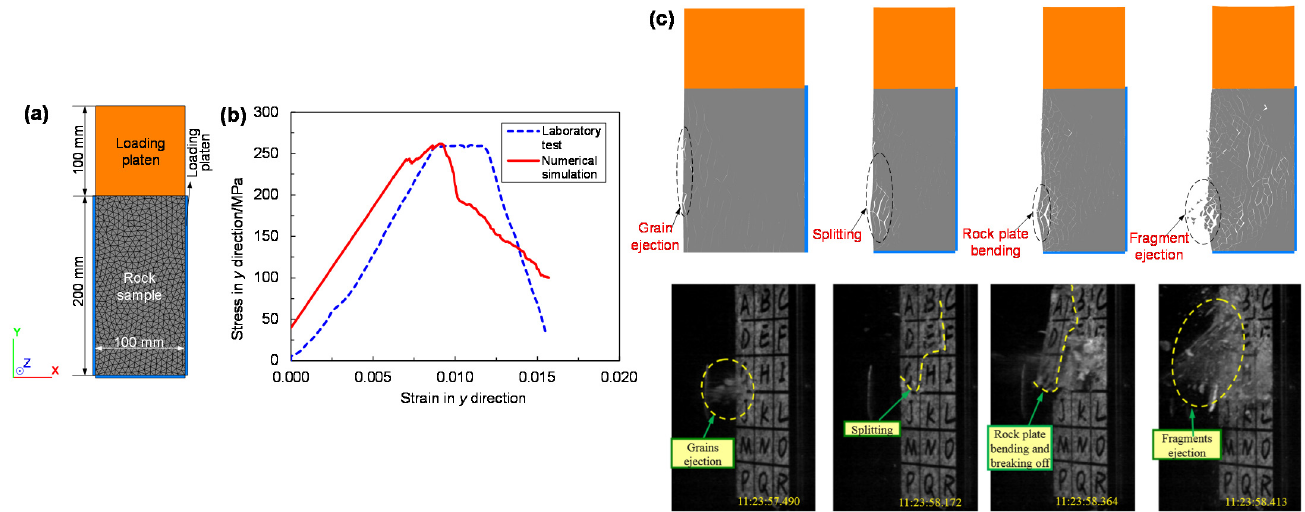
Figure 2. A numerical model for simulating self-initiated strainbursts and the comparison between the simulation and experimental results: ( a ) numerical model; ( b ) stress-strain curves obtained by the simulation and laboratory test [35]; ( c ) comparison between simulated failure stages and modes and experimental observations [35].